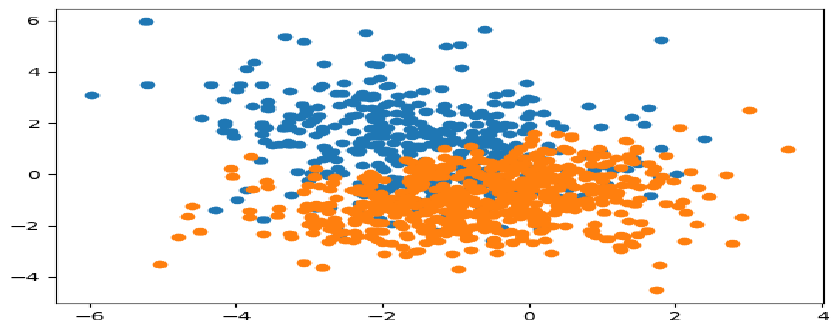
Figure 3. Simulated results for two clusters showing states of the sensor with 6 features.